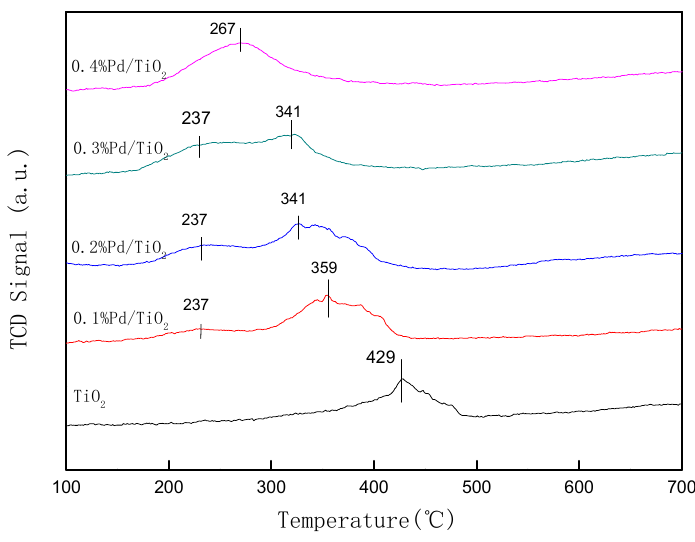
Figure 3. H 2 -TPR profiles of Pd/TiO 2 catalysts.